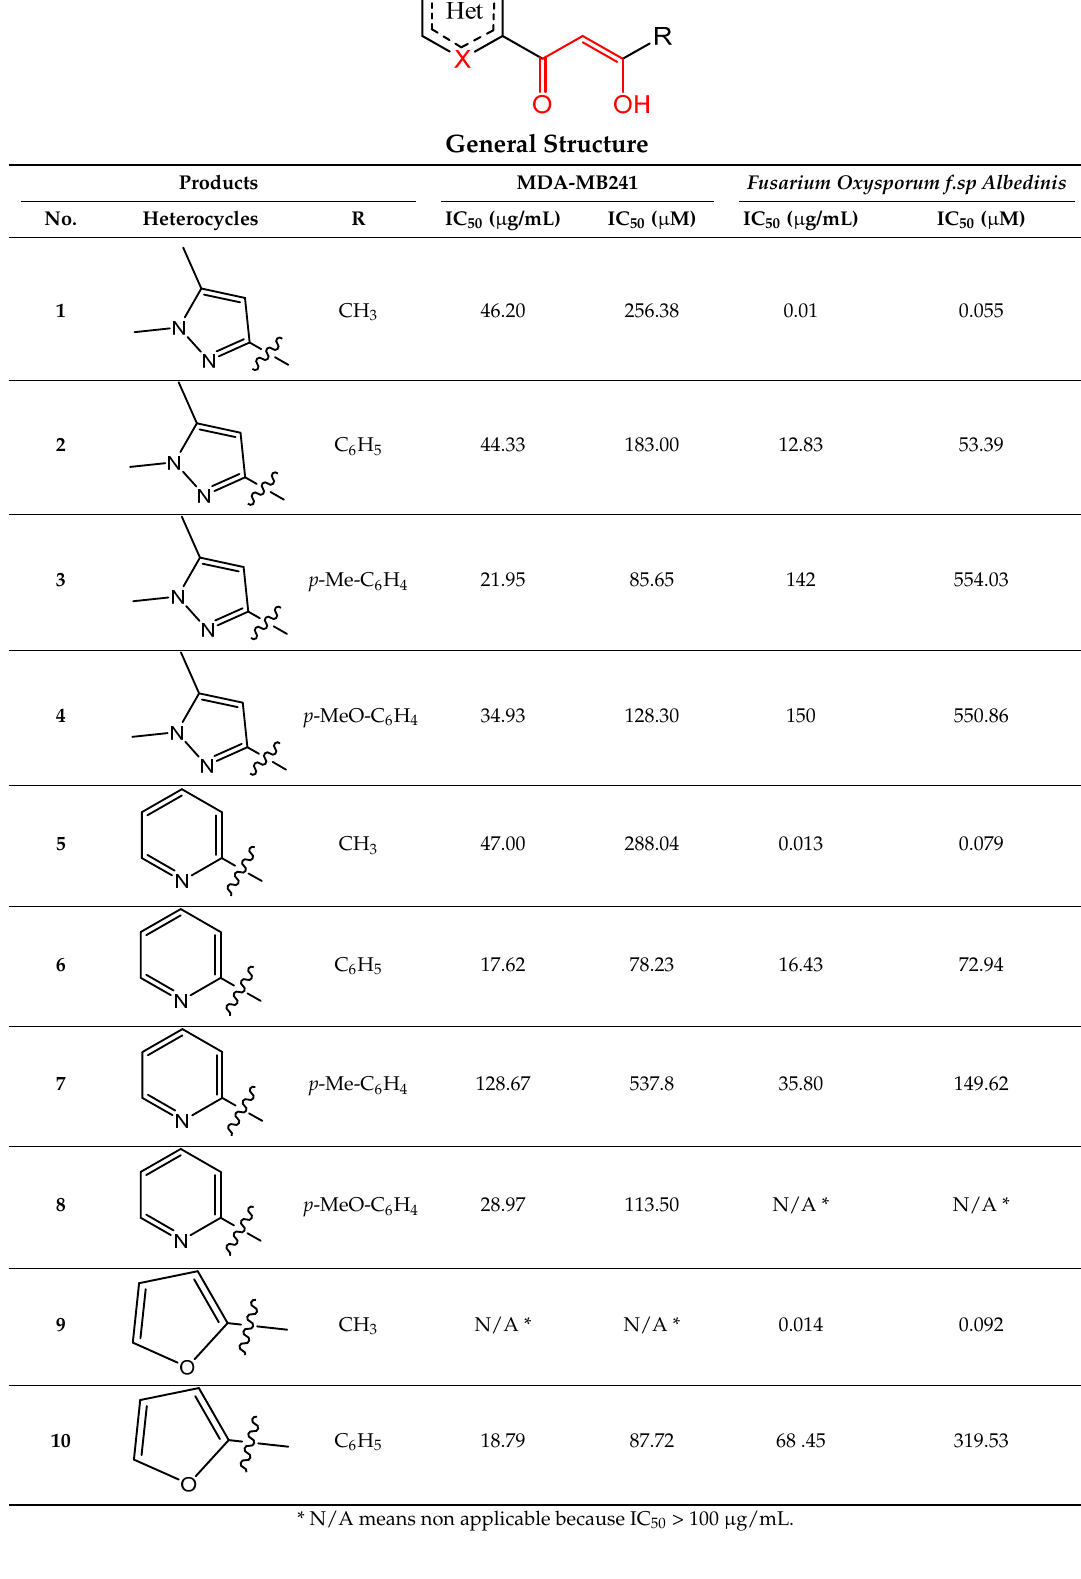
Table 1. Breast cancer and fungal inhibitory activities of synthesized heterocycle β -keto-enols.